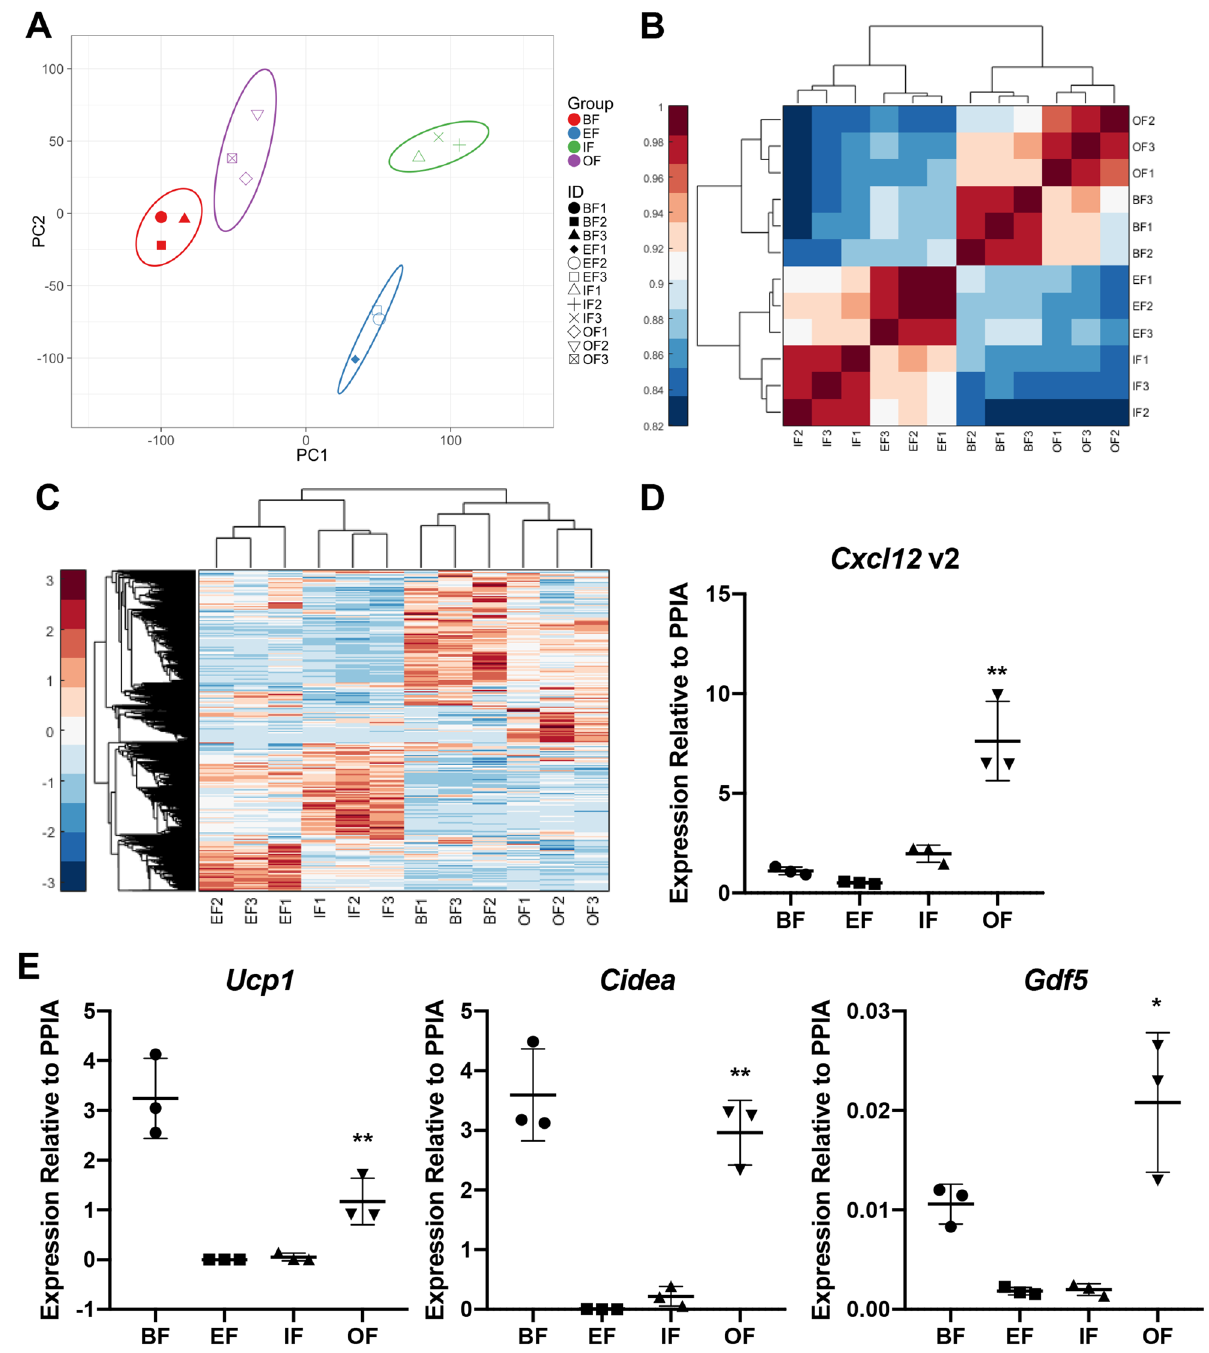
Figure 2. Transcriptomic analysis of murine fat depots reveals significant similarity between orbital fat and interscapular brown fat. ( A ) Principal component analysis of transcriptome data from mouse brown fat (BF), epididymal fat (EF), inguinal fat (IF) and orbital fat (OF) demonstrates that BF and OF segregate more closely to each other than to EF and IF. ( B ) Sample-wise correlation of transcriptome data from BF, EF, IF and OF demonstrates that transcriptome of OF is more closely correlated with that of BF than with the transcriptomes of EF and IF. ( C ) Heat map of transcriptome data from mouse BF, EF, IF and OF demonstrates more significant shared gene expression between OF and BF. There is less significant overlap between OF and either EF or IF. Heatmap was created using Matlab 2018. ( D ) qPCR validates transcriptome data, demonstrating that Cxcl12 transcript variant 2 is enriched in orbital fat (OF) compared to brown fat (BF), epididymal fat (EF), and inguinal fat (IF). ** indicates p < 0.0001 by one-way Anova. ( E ) qPCR demonstrates that brown fat markers Ucp1 , Cidea , and Gdf5 are enriched in murine BF and OF compared to EF and IF. ** indicates p < 0.0001 by one-way Anova. * indicates p = 0.006 by one-way